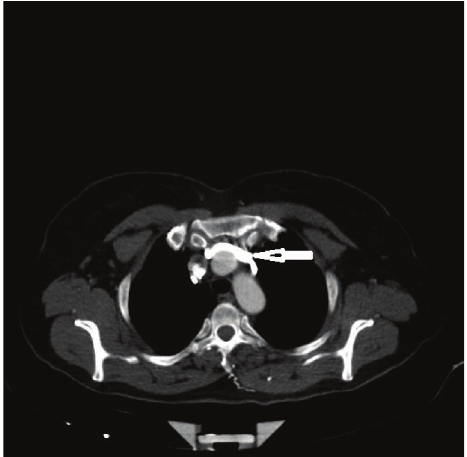
Figure 2: Right azygos vein was discharging the superior vena cava (arrows).